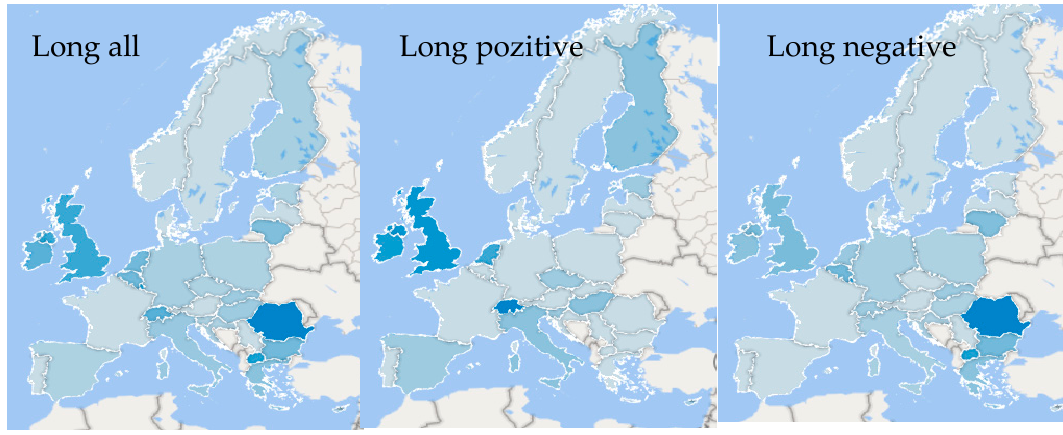
Figure 12. Number of precedence by country, first precedencies group Eco, by effect. Geospatial distribution.